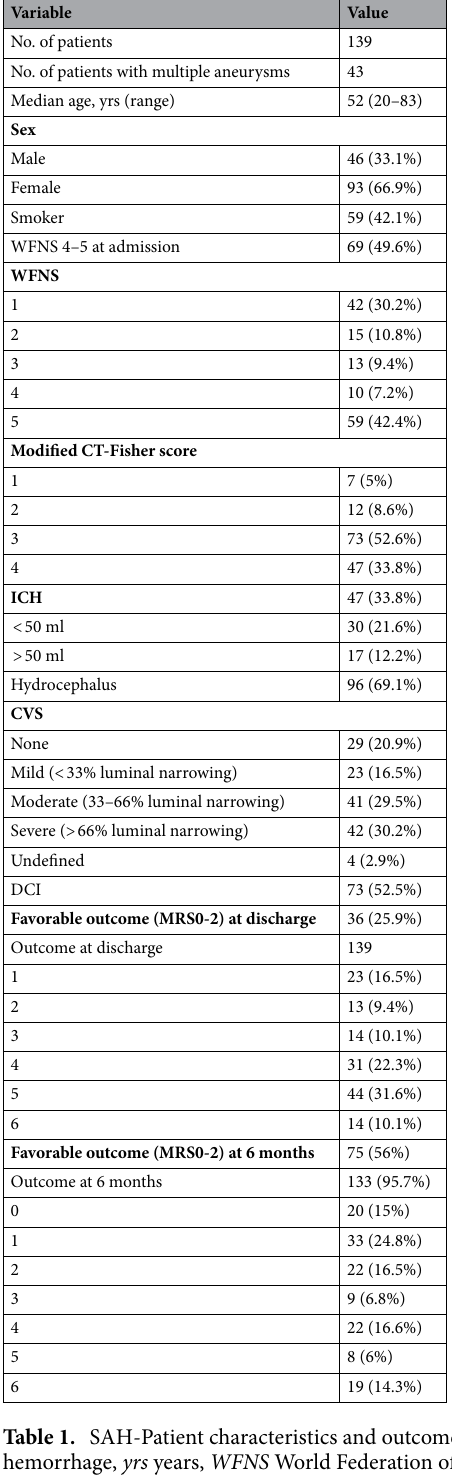
Table 1. SAH-Patient characteristics and outcome at discharge as well as at follow up. SAH subarachnoid hemorrhage, yrs years, WFNS World Federation of Neurological Surgeons, ICH intracerebral hemorrhage, CVS cerebral vasospasm, DCI delayed cerebral ischemia, MRS modified Rankin